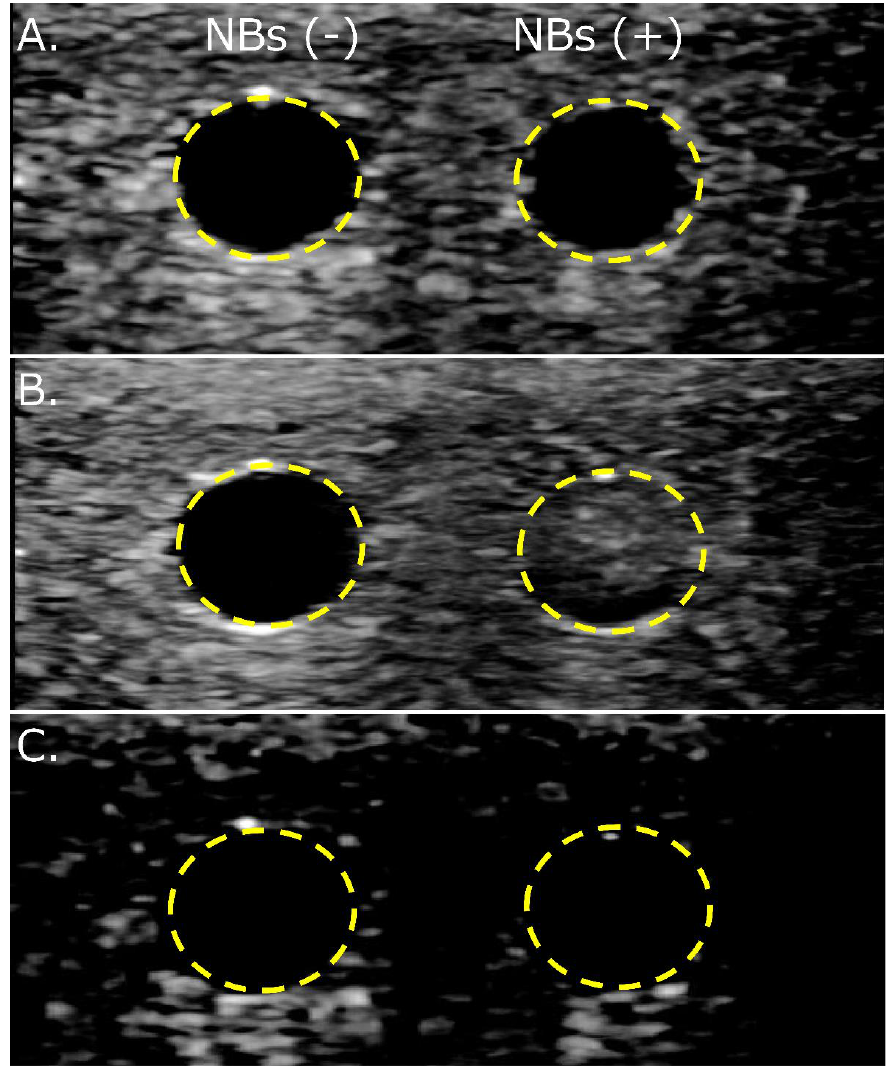
Figure 7. Detection of changes in echo brightness in solution with and without nanobubbles regen- erated from lyophilized material using flow phantom vessels. ( A ) B-mode only. ( B ) B-mode with Coded Harmonic Angio (CHA). ( C ) B-mode with Amplitude Modulation (AM). NBs (−): solution without nanobubbles, NBs (+): solution with nanobubbles.